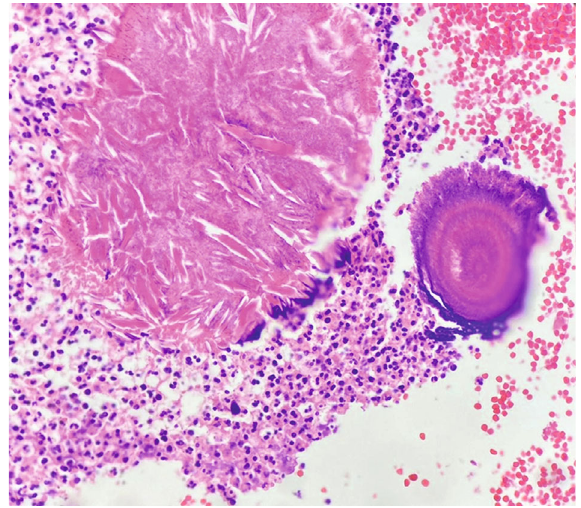
Figure 3: Microscopic fi ndings of fi broconnective tissue containing few crushed bone particles severely in fi ltrated by acute in fl ammatory cells and some foamy macrophages (H&E staining, magni fi cation level 10 × 40